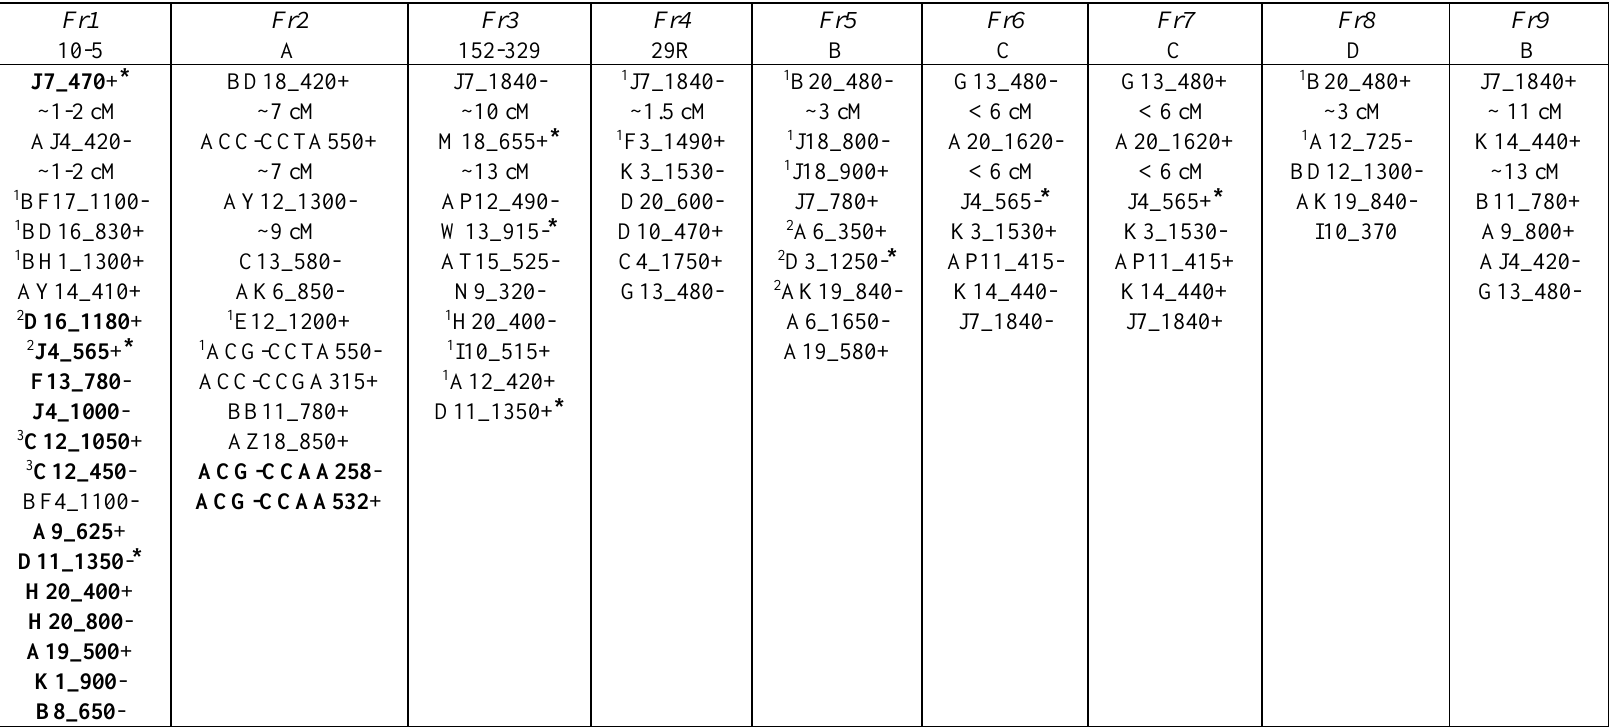
Table 2. Listing of RAPD and AFLP markers significantly linked at LOD ≥ 3.00 with fusiform rust disease resistance genes ( Fr1 – Fr9 ) in their respective loblolly pine selections (e.g., Fr1 in selection 10-5). AFLP markers were used only in selection A. Map distance in cM is given for some of the closer markers for each Fr gene. Other markers (without cM designations) are listed with regard to proximity (order from top to bottom approximates near to far) to the Fr gene in the selection. Within a column marker names followed by a (+) have the band-present marker allele linked with the resistance allele, while marker names followed by a (-) have the band-absent marker allele linked with the resistance allele. Within a column markers preceded by the same superscript number were non-recombinant with each other in the mapping population. For markers followed by a superscript * , marker size (estimated in base pairs) is revised from previous citation (e.g., marker J4_565 was previously called J4_550). Listed marker sizes represent preferred usage. For Fr1 , bold markers were previously reported (19, 40). For Fr2 , the two bolded markers were not previously reported (41). For Fr3 , all makers were previously reported